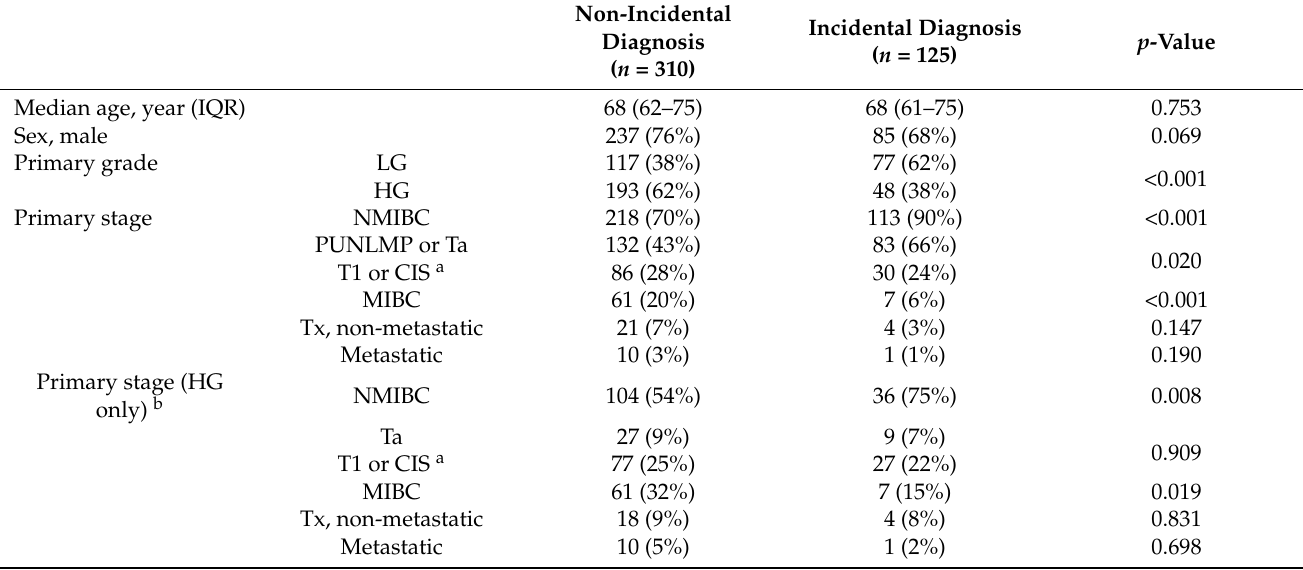
Table 1. Patient